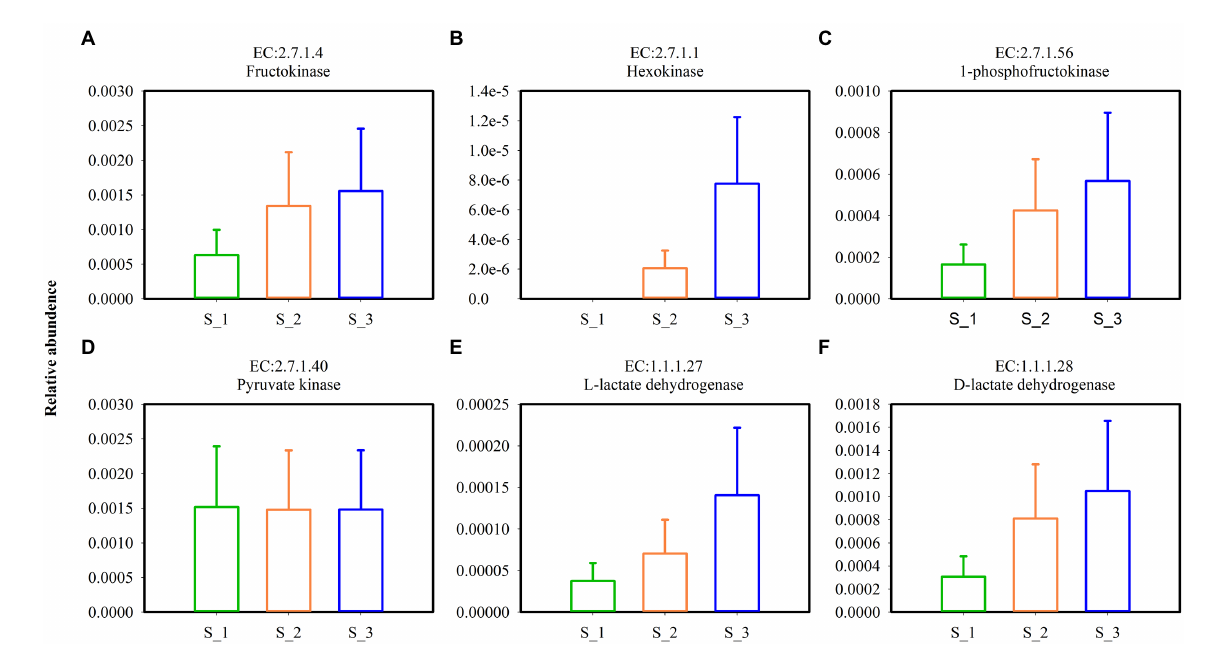
FIGURE 9 Key enzymes involved in glycolytic pathway (A–D) and lactate dehydrogenase (E,F) in the three cutting alfalfa silage. S_1, ensiled alfalfa in the first cutting, S_2, ensiled alfalfa in the second cutting, S_3, ensiled alfalfa in the third cutting. The green non-filled bar indicate S_1, the orange non-filled bar indicate S_2, the blue non-filled bar indicate S_3. EC, reference metabolic pathway highlighting numbers; means within the same column with different letters differ significantly from each other ( p <